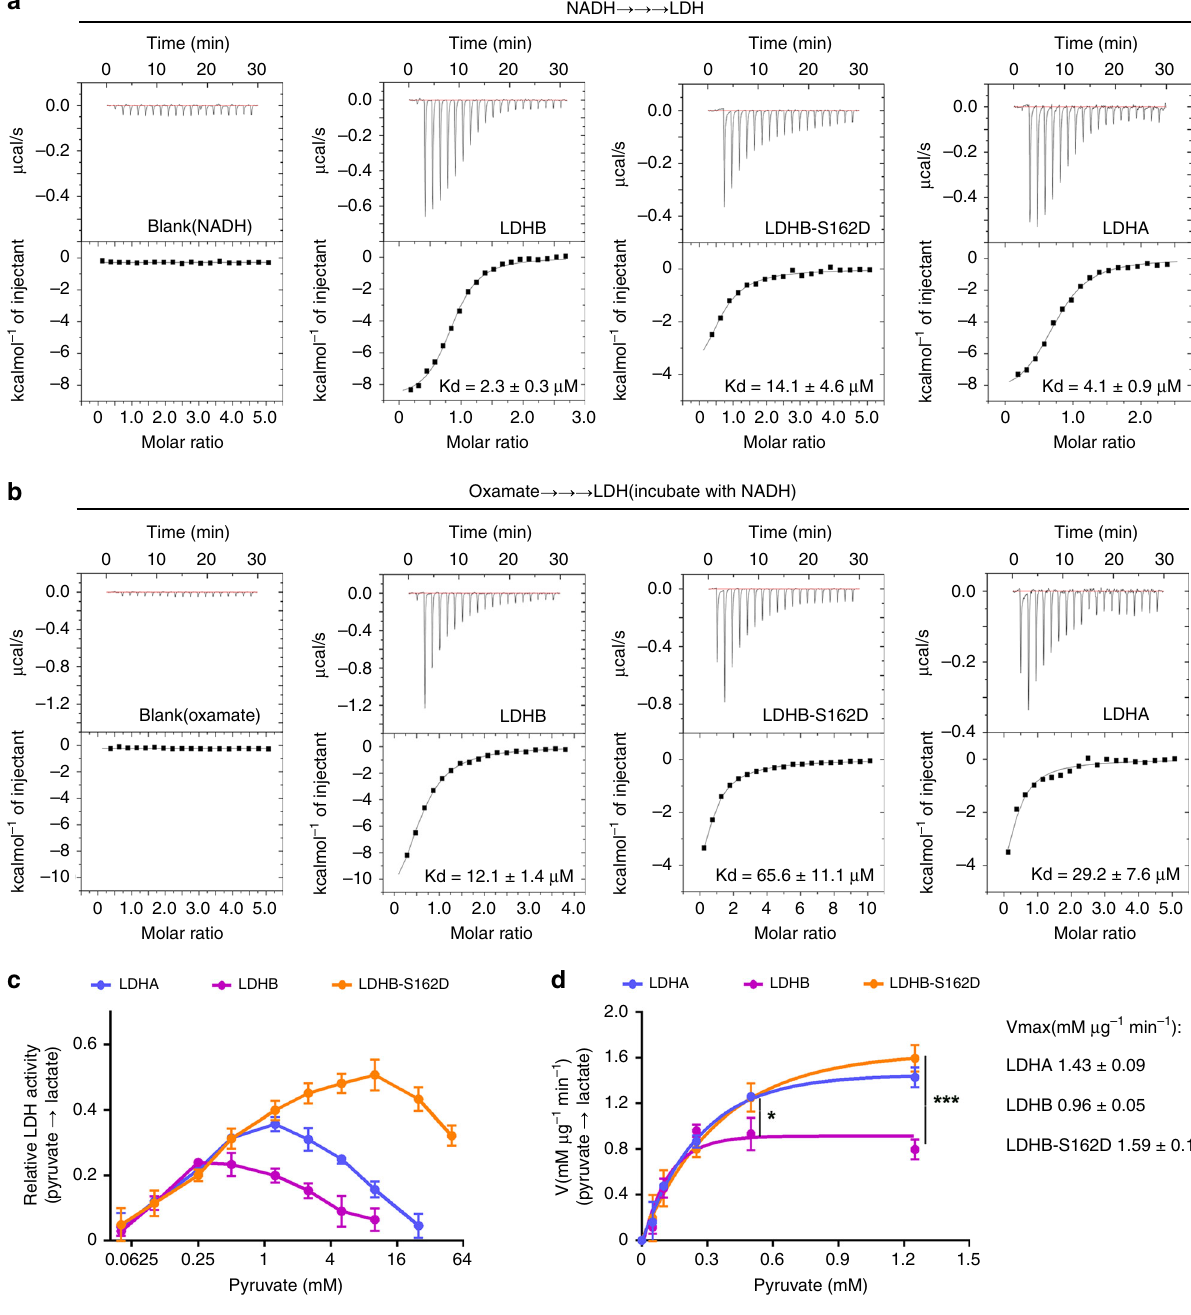
Fig. 4 The substrate-inhibition effect was relieved by LDHB-S162D. a The dissociation constant of NADH for LDH was assessed by isothermal titration calorimetry (ITC) assay. ITC results were shown for interactions of NADH with LDHB, LDHB-S162D, and LDHA. The K d values were labeled at the bottom. b ITC results were shown for oxamate interactions with LDHB-NADH complex, LDHB-S162D-NADH complex and LDHA-NADH complex. The K d values were labeled at the bottom. c The catalytic activity (Pyruvate to lactate) of LDHA, LDHB, and LDHB S162D were measured at different concentrations of pyruvate. The relative enzyme activity for LDHB, LDHB-S162D, and LDHA were plotted against the concentrations of pyruvate (logarithm of 2). d The catalytic rates of the forward reactions for LDHA, LDHB and LDHB S162D were plotted over physiological concentrations of pyruvate. Student t -test were performed between the rate of LDHB and LDHB S162D at 0.5 and 1.25 mM pyruvate. Curve fi tting was conducted using Prism software. The error bar in panels a , b , c , d represents the standard error of mean(SEM), n = 6 independent experiments for LDHB, 7 for LDHB-S162D, 4 for LDHA in panels a , n = 4 independent experiments for LDHB, 6 for LDHB-S162D, 4 for LDHA in panels b , n = 4 independent experiments for LDHB, 3 for LDHB-S162D, 4 for LDHA in panels c and d . Source data are provided as a Source Data fi les. (Student ’ s t -test * p < 0.05, ** p < 0.01, *** p < 0.001, ns not signi fi